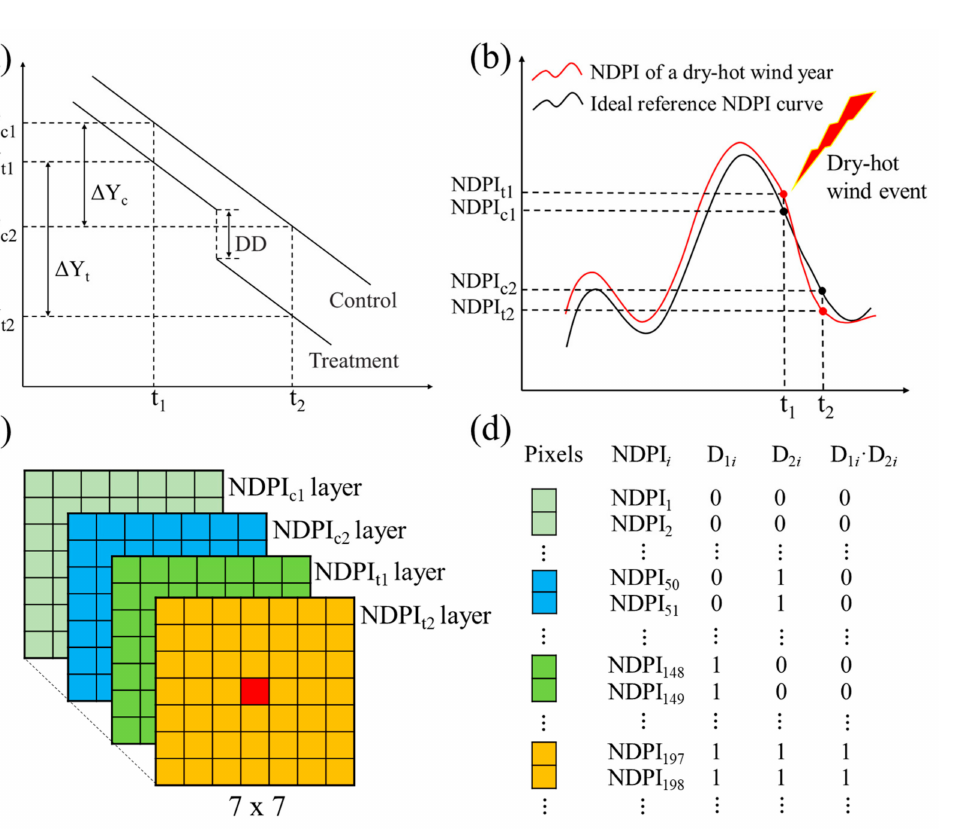
Figure 3. The conceptual framework of the DID-based method to monitor dry-hot wind damage to winter wheat. ( a ) illustrates the basic principle of DID model; ( b ) is a schematic diagram of using DID model to monitor dry-hot wind disaster for winter wheat; ( c ) represents four NDPI matrices within a 7 × 7 moving window centered on a target wheat pixel (i.e., before/after dry-hot wind and the treatment/control group); ( d ) is tabular form of wheat pixels reassembled pixel by pixel from the four NDPI matrices in ( c ). These pixels are then used for DID model